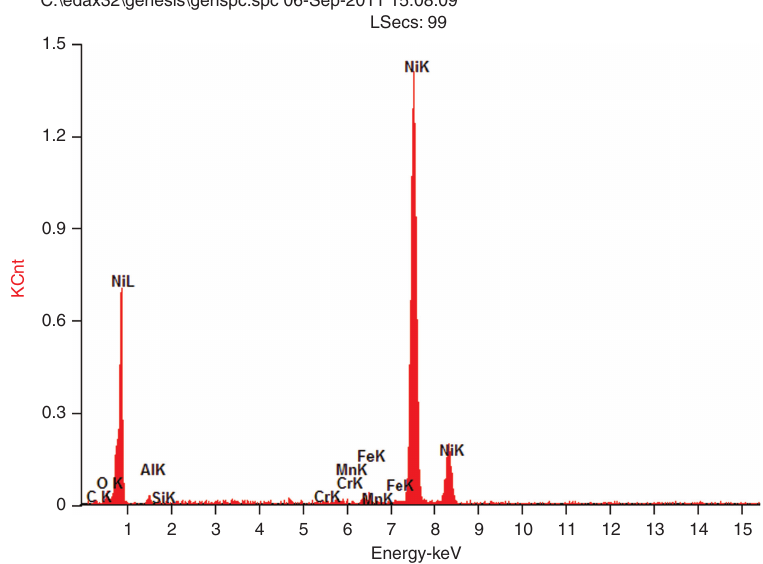
O composites of AISI 304 stainless steel 2 3